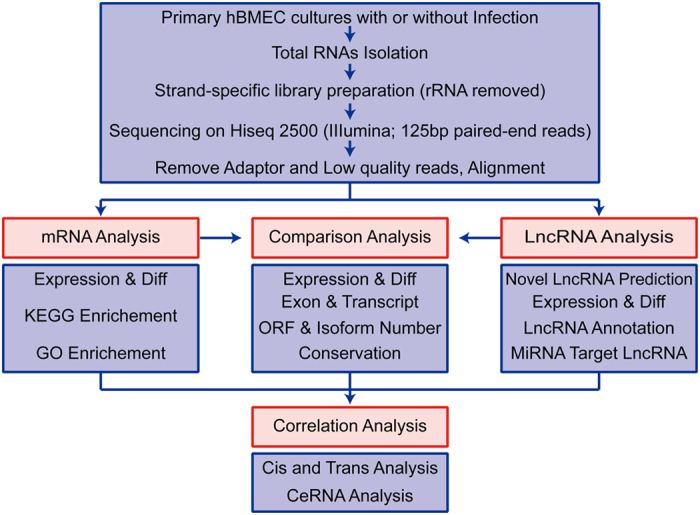
Overview of the RNA-sequencing processes and bioinformatic analysis.